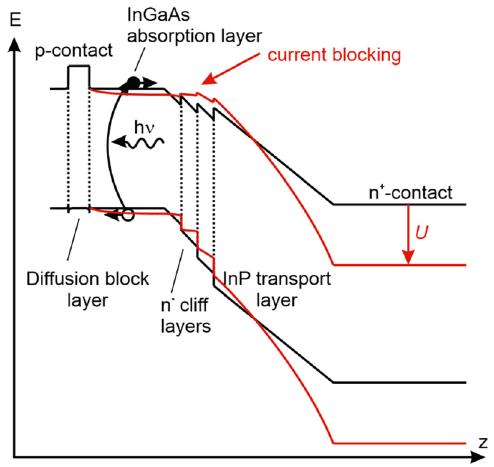
Figure 6: Band structure of an UTC diode in the dark (unbiased, black) and illuminated conditions (reverse-biased, red). The vertical axis represents the energy level E , while the horizontal axis the spatial z-coordinate. U represents the applied bias. The UTC diode suffers from current blocking at high optical power levels. The effect is less severe if the transport layer is slightly